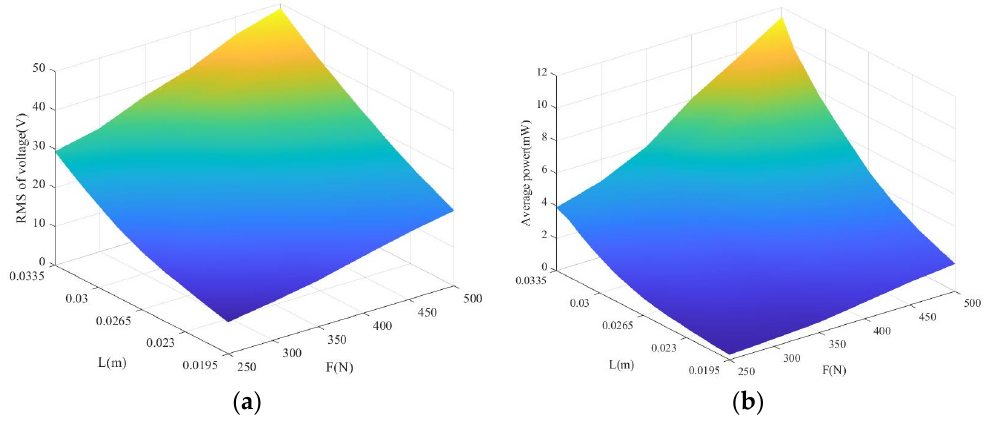
Figure 20. RMS of voltages and average powers from 1#1 PZT4 patch of 1# piezoelectric brick with Spring steel substrate versus the force arm length of LPCB and the footstep excitation amplitude. ( a ) RMS of voltages; ( b ) Average powers.